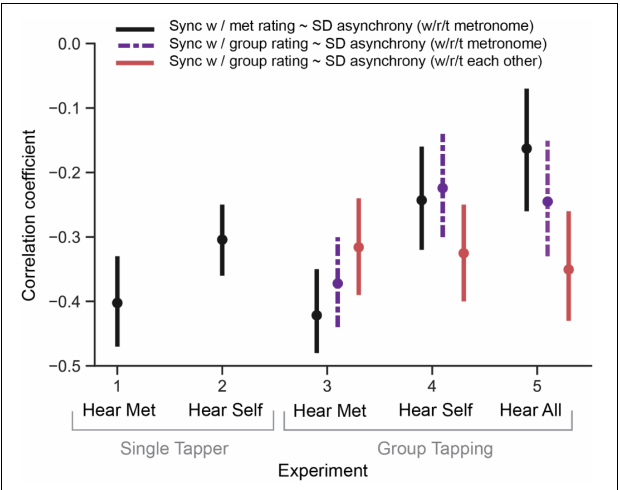
FIGURE 5 | Correlations between motor tapping asynchrony and subjectively rated synchrony with the metronome in all experiments. Note that in group tapping experiments, we have additional data about how in synchrony participants felt with the group. We analyzed that data separately as a function of synchrony with respect to the metronome (dotted purple line) and synchrony with respect to everyone in the group (red line). Error bars represent confidence intervals of the correlation